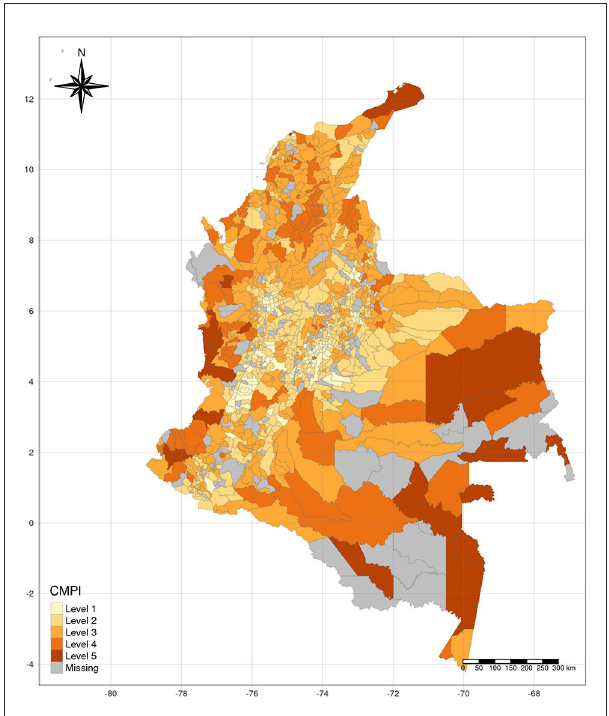
FIGURE1 CPMI levels in Colombian municipalities, where notification of patients hospitalized for COVID-19 was made during 2020–2021.